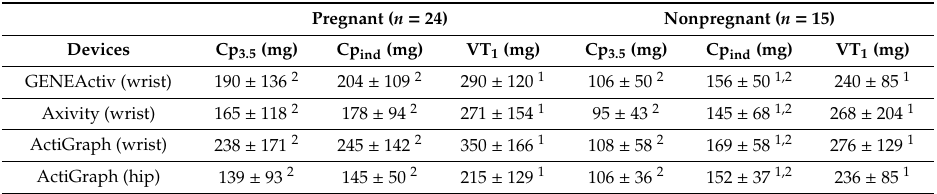
Table 2. Metric Euclidian norm minus one (ENMO) of the determined accelerometer cut points of the di ff erent devices for pregnant and nonpregnant women. Pregnant ( n = 24) Nonpregnant ( n = 15) Cp 3.5 (mg)